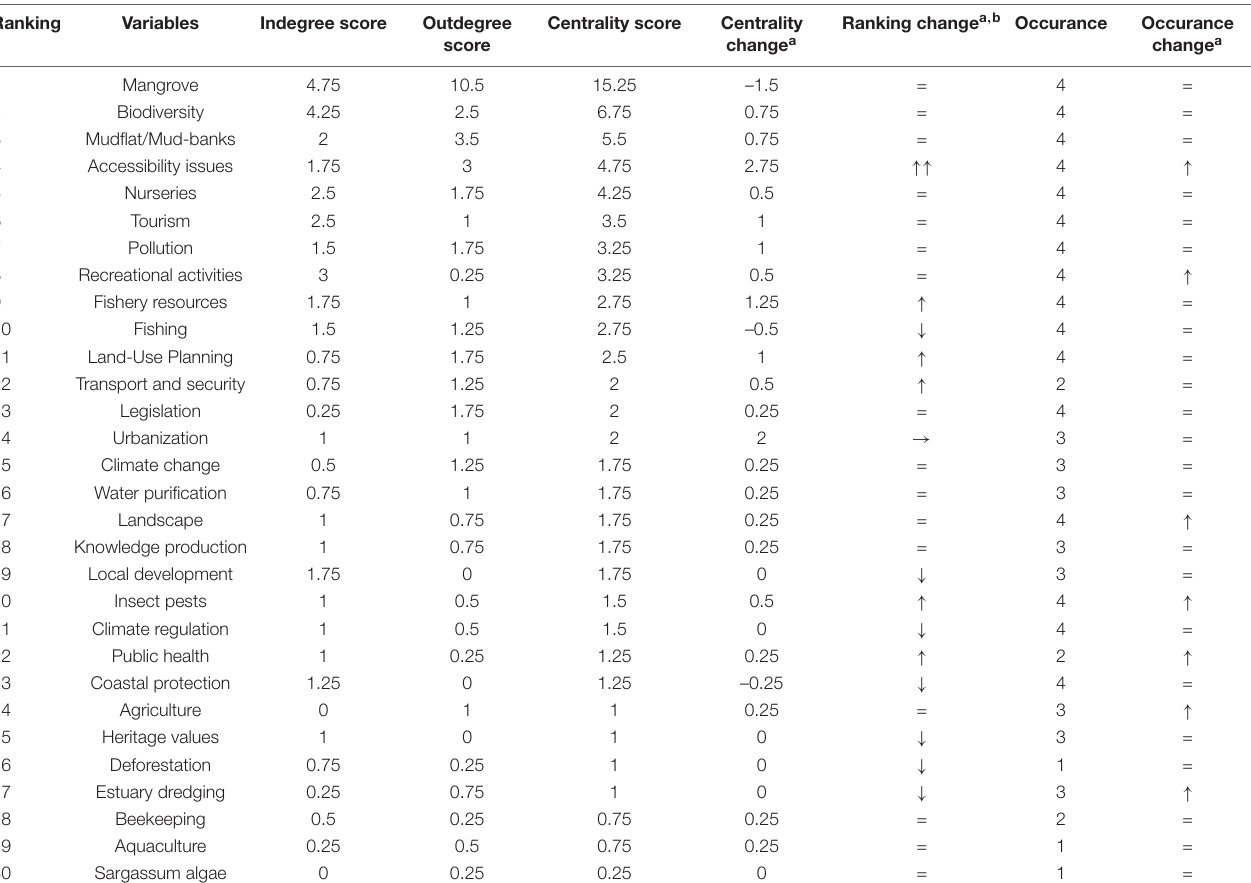
TABLE 4 | Indices regarding variables of the community